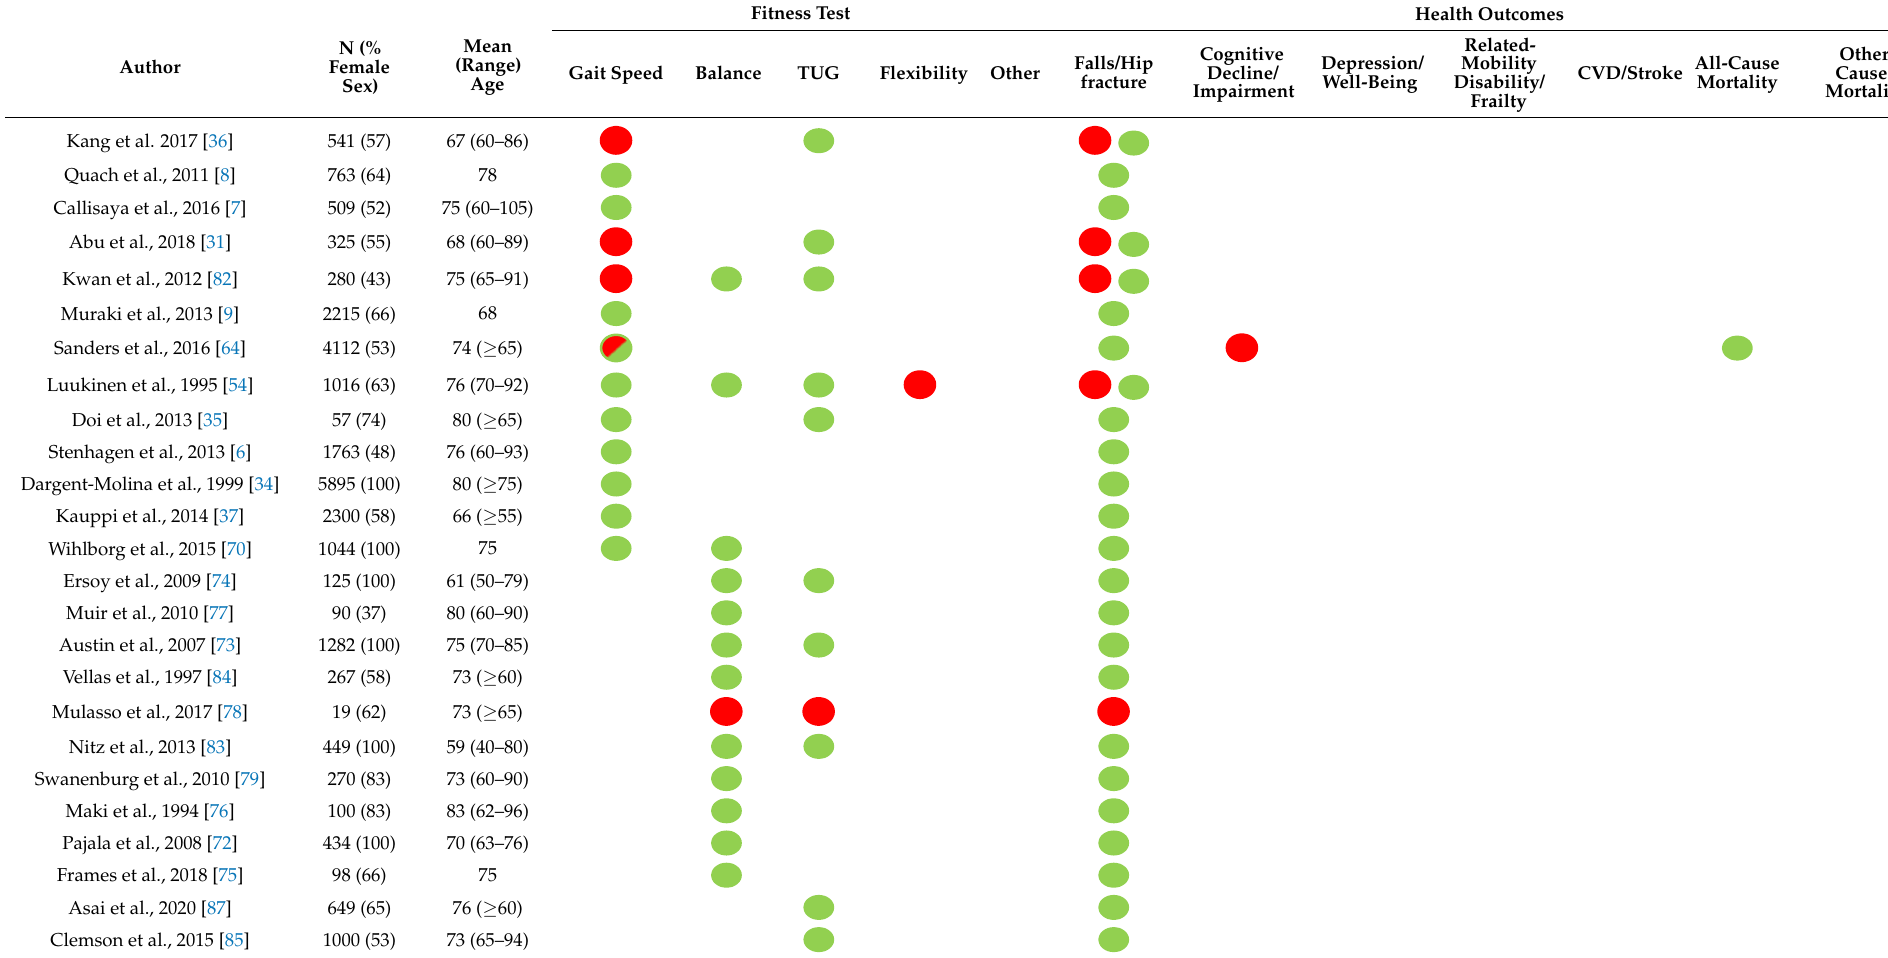
Table 3. Main characteristics and findings of longitudinal studies investigating the predictive validity of motor fitness and flexibility tests for health outcomes in adults and older adults.